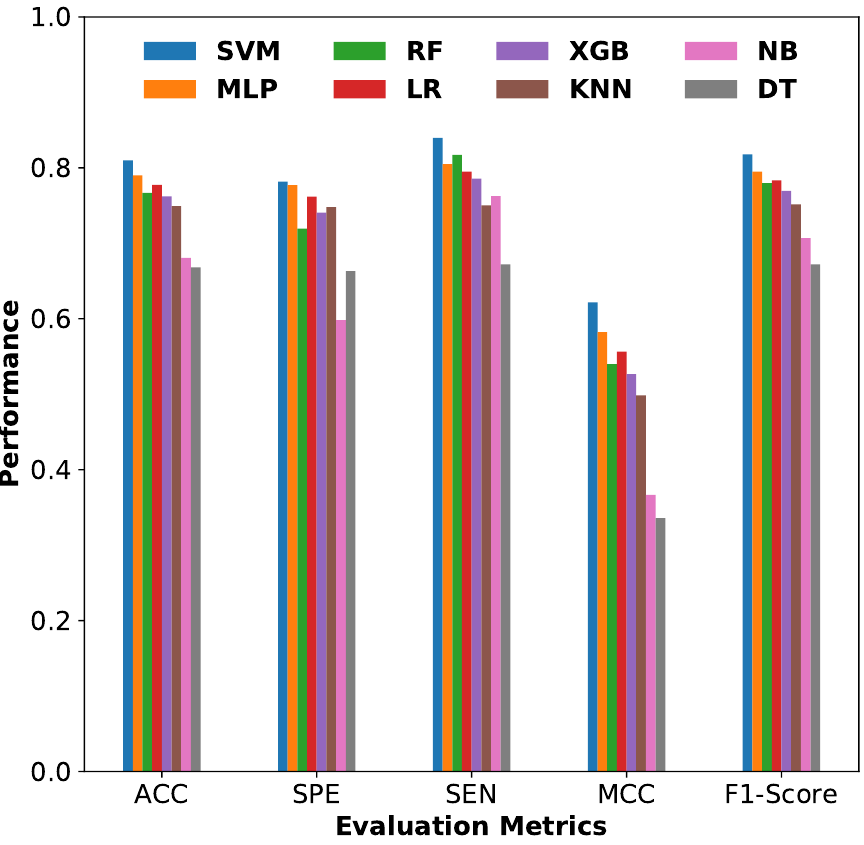
Figure 8. Performance comparison of various classifiers using 10-fold